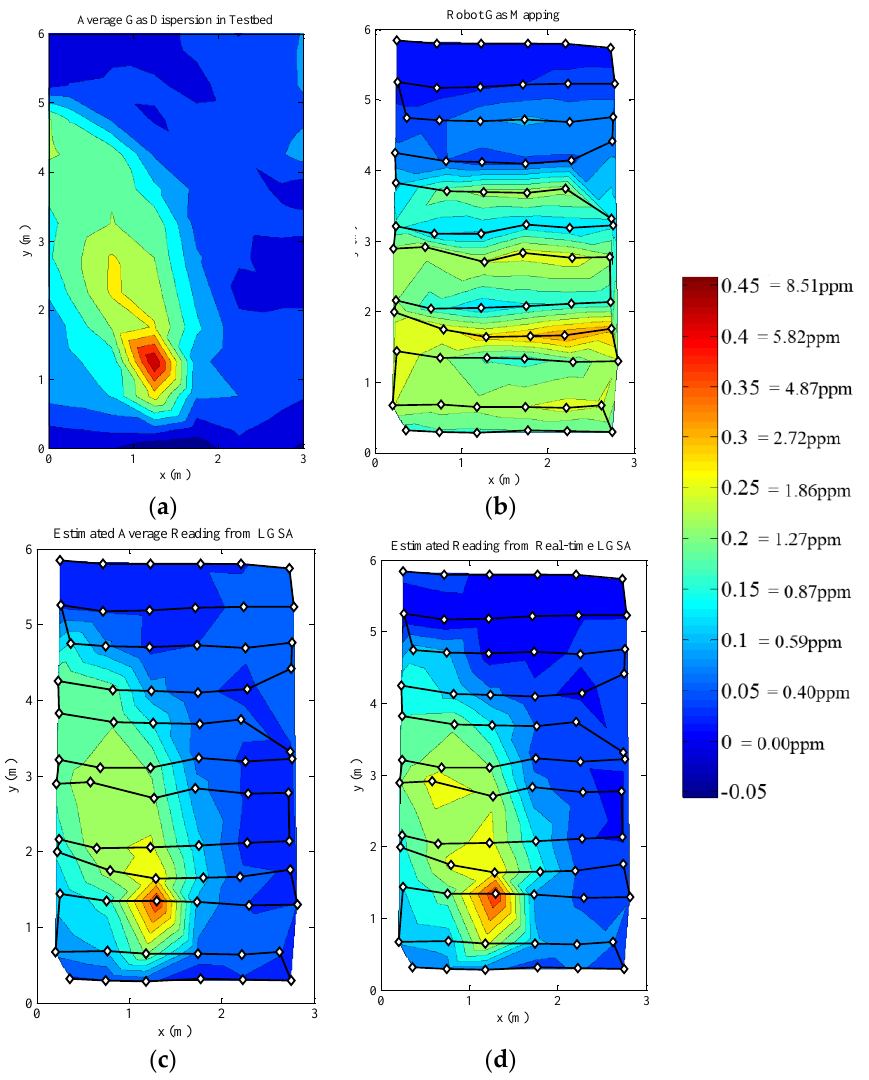
Figure 16. Gas distribution plots of constantly moving robot experiment. The robot’s movement path is denoted by the line and the dots indicate measurement points. The robot starts at the top right corner of the map. ( a ) The averaged LGSA reading for the duration of the experiment; ( b ) The measured gas concentration by the robot; ( c ) The ground truth robot reading estimated from the averaged LGSA measurement; ( d ) The ground truth robot reading estimated from the real-time LGSA measurements.